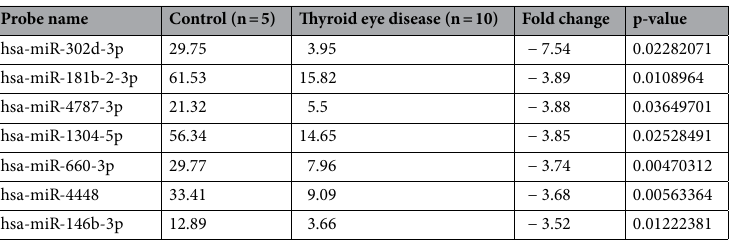
Table 2. List of the seven top-ranked miRNAs with significantly different serum levels in healthy controls and patients with thyroid eye disease.